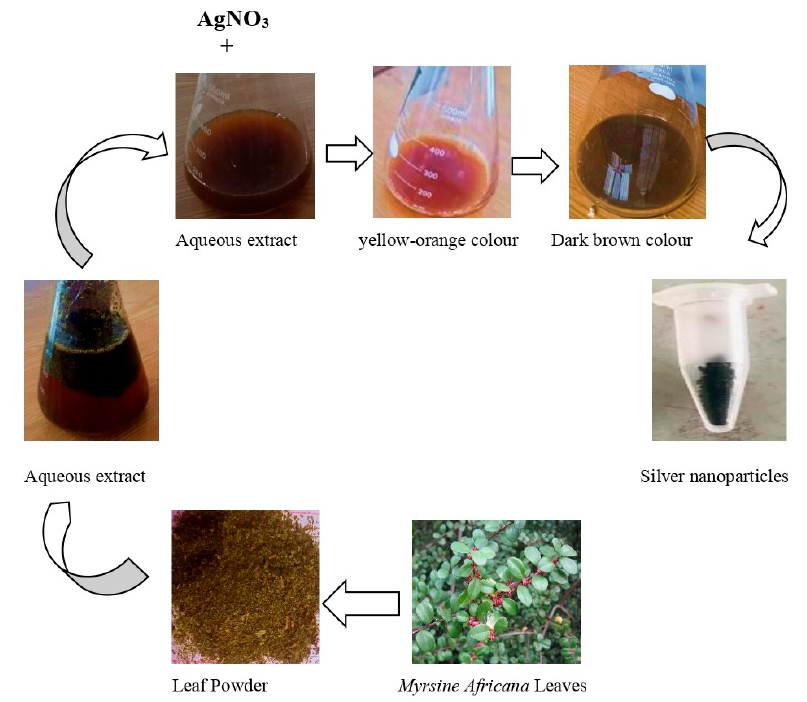
Figure 1. Schematic representation of synthesis of silver nanoparticles using M. africana leaf extract.